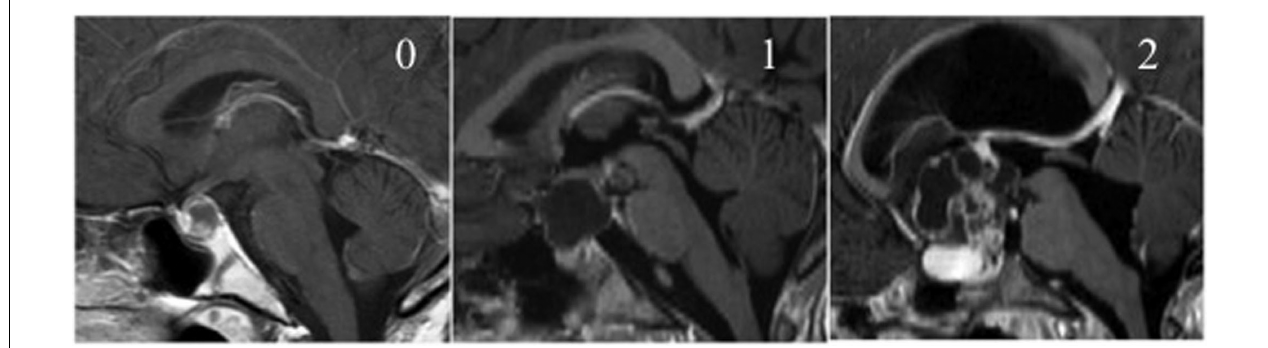
FIGURE 1 | Pre-operative MRI classification according to hypothalamic involvement. Type 0 pre-op: no involvement of the hypothalamus,Type 1 pre-op: distortion/elevation of the hypothalamus,Type 2 pre-op: the hypothalamus is not visible due to tumor